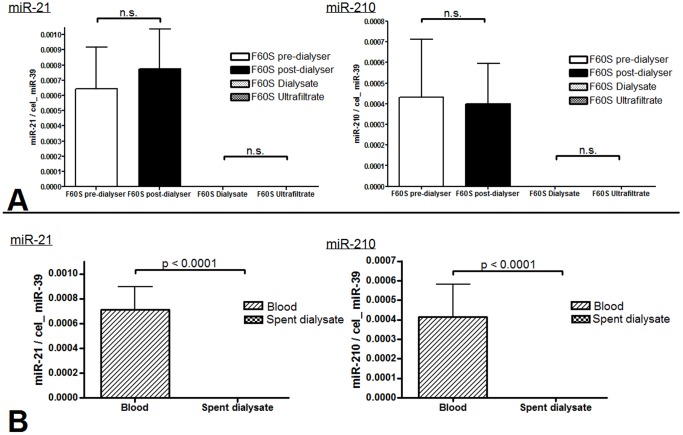
Levels of circulating miR-21 and -210 in different sample types with the F60S dialysate filter.Ten independent dialysis sessions in eight different patients were analyzed for the F60S filter system. MiR-21 and miR-210 levels are not significantly different between pre-dialyser and corresponding post-dialyser blood lines (miR-21: p = 0.35; miR-210: p = 0.91). Also the difference between spent dialysate and ultrafiltrate is not of statistical significance (miR-21: p = 0.80; miR-210: p = 0.74). However, averaged values of blood side versus spent dialysate reached high statistical significance for both microRNAs with p-values of <0.0001. Data are represented as mean and standard error of the mean.